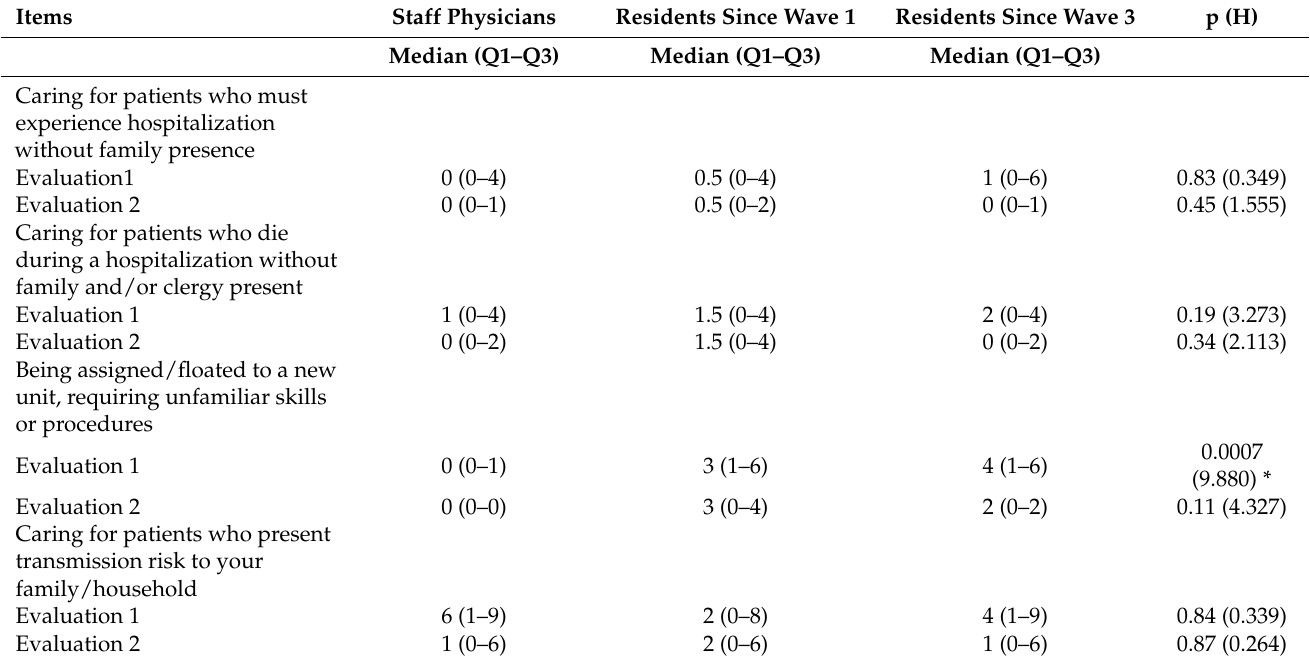
Table 3. Summary of responses to the moral distress items on COVID-19 situations of 108 physicians according to the experience group during the two evaluations. Comparisons among groups were performed by Kruskal Wallis ANOVA.